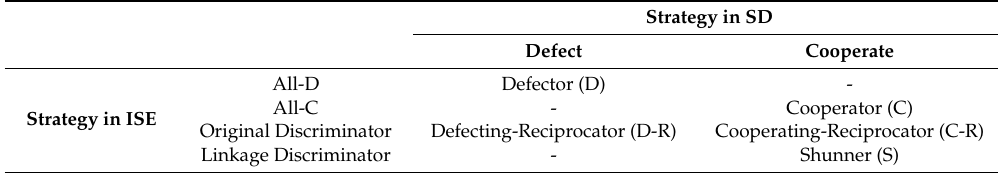
Table 2. Strategies used in the current